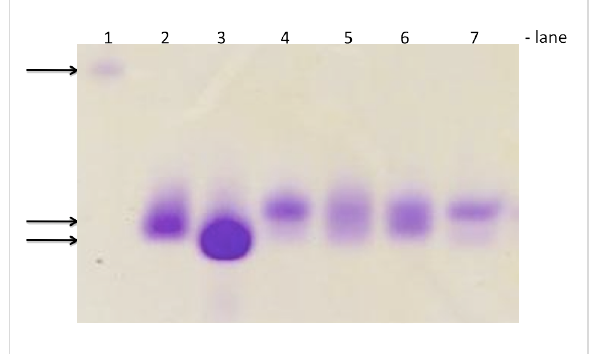
Figure 3: Denaturing PAGE of ligation products of truncated suppressor tRNA and fluorinated aminoacyl-pdCpAs and Abu-pdCpA. Lane 1: RNA Marker 100 bp, Lane 2: transcribed full-length tRNA CUA , Lane 3: transcribed truncated tRNA CUA -C OH , Lane 4: Abu-tRNA CUA , Lane 5: DfeGly-tRNA CUA , Lane 6: TfeGly-tRNA CUA , Lane 7: α -(Tfm)Ala-tRNA CUA . Amino groups are N -(4-pentenoyl) protected. Visualized by using Stains-all (Sigma-Aldrich ®